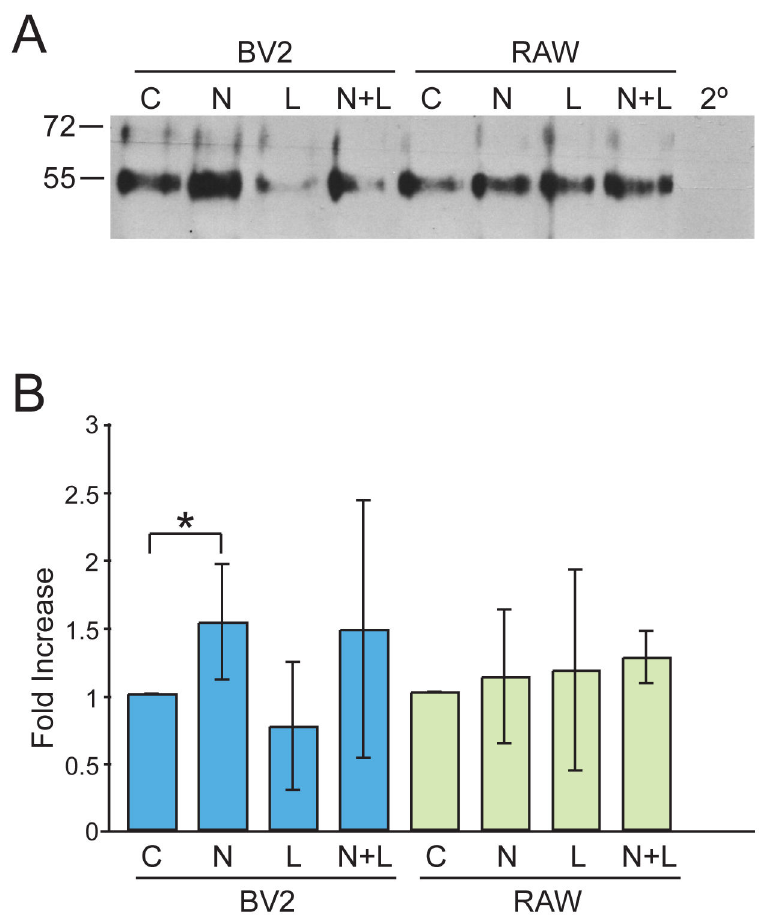
Figure 2. NRG increases α7nAChR expression in microglia and macrophages. Microglia (BV-2) and macrophage (RAW) cell cultures were treated overnight with NRG (N) or left untreated (C). LPS (L) was added to activate cells four hours prior to extraction. Protein extracts were then precipitated with biotin-conjugated α-BTX and streptavidin agarose beads. Panel A is a representative immunoblot probed with anti-α7nAChR antisera. The α7nAChR band is shown at approximately 55kDa. Subsequent densitometric analysis of immunoblots shows a 1.53 ± 0.42 fold increase in α7nAChRs over control in NRG treated BV-2 cells (n=3, p <0.05, t- test). BV-2 cells appeared to show a decrease in α7nAChR expression when treated with LPS, 0.76 ± 0.47 compared to untreated cells, however LPS effect on BV-2 cells was variable. RAW264.7 cells treated with NRG showed a 1.11± 0.49 fold increase over untreated cells. Taken together our results indicate that NRG increases α7nAChR expression in BV-2 cells but have little effect in RAW264.7 cells. Values are means ± SEM. Error bars represent